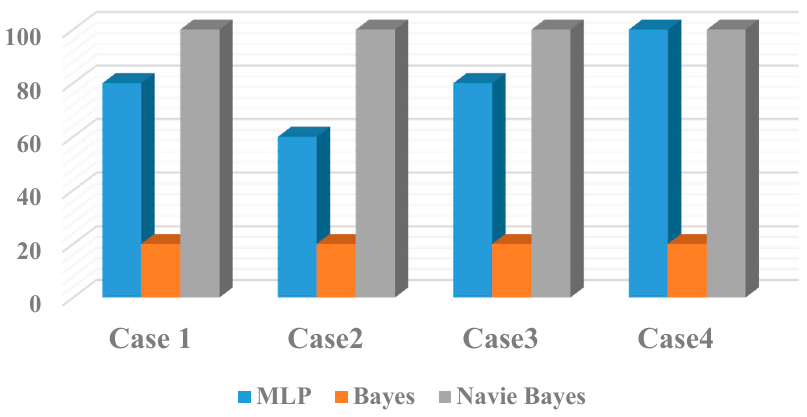
Figure 14. Accuracy rate of the classifiers.